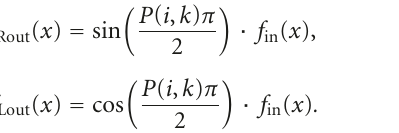
range. Initially, all sources are placed in the centre. The available panning steps are calculated for every di ff erent accumulated filter, k , where k ranges from 1 to K , based on the number of sources, N k , whose dominant frequency range resides in that filter. Due to this channel dependency the algorithm will update itself every time a new input is detected in a new channel, or if the spectral content of an input channel su ff ers from a drastic change over time. For filters which have not reached maximum accumu- lation there is no need to calculate the panning step, which makes the algorithm less computationally expensive. If only one repetition exists for a given k th filter ( N k = 1) the system places the input at the